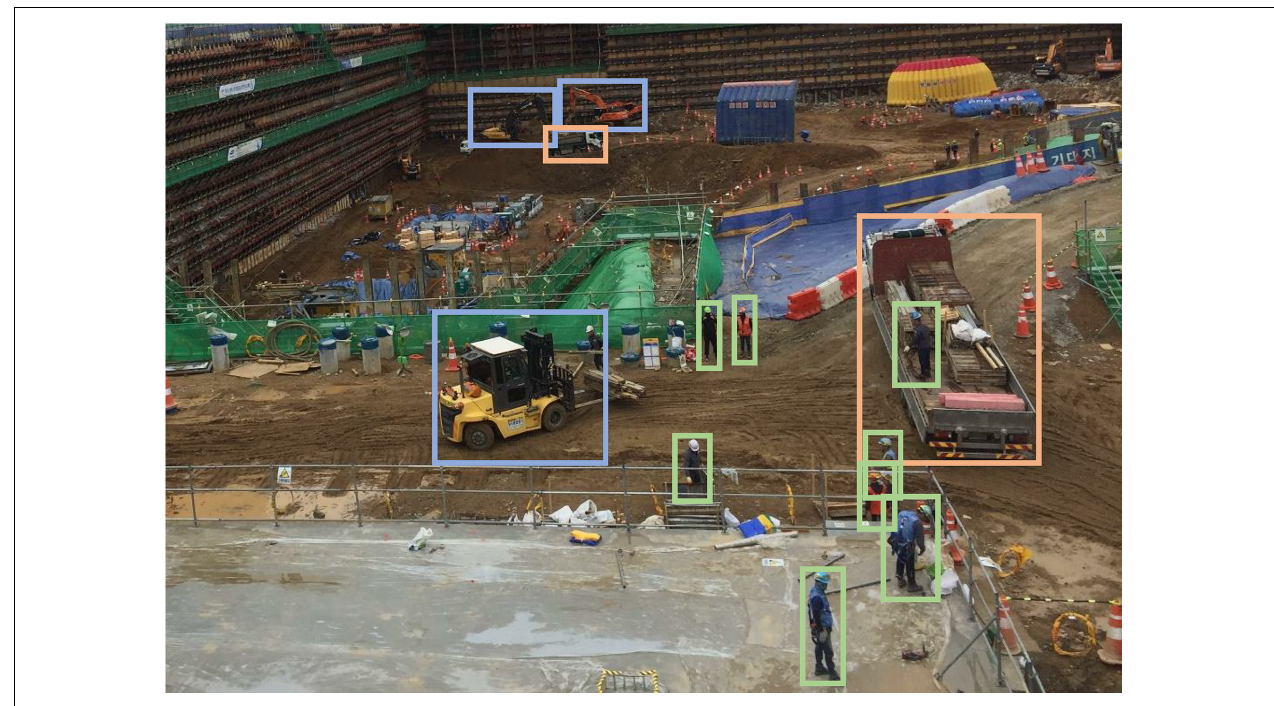
FIGURE 5 | Examples of construction object